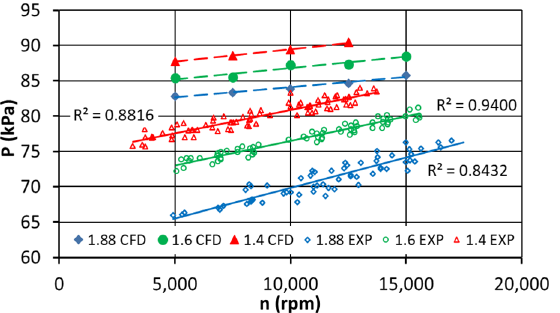
Figure 10. Pressure in the plenum chamber as a function of rotational speed for different pressure ratios.